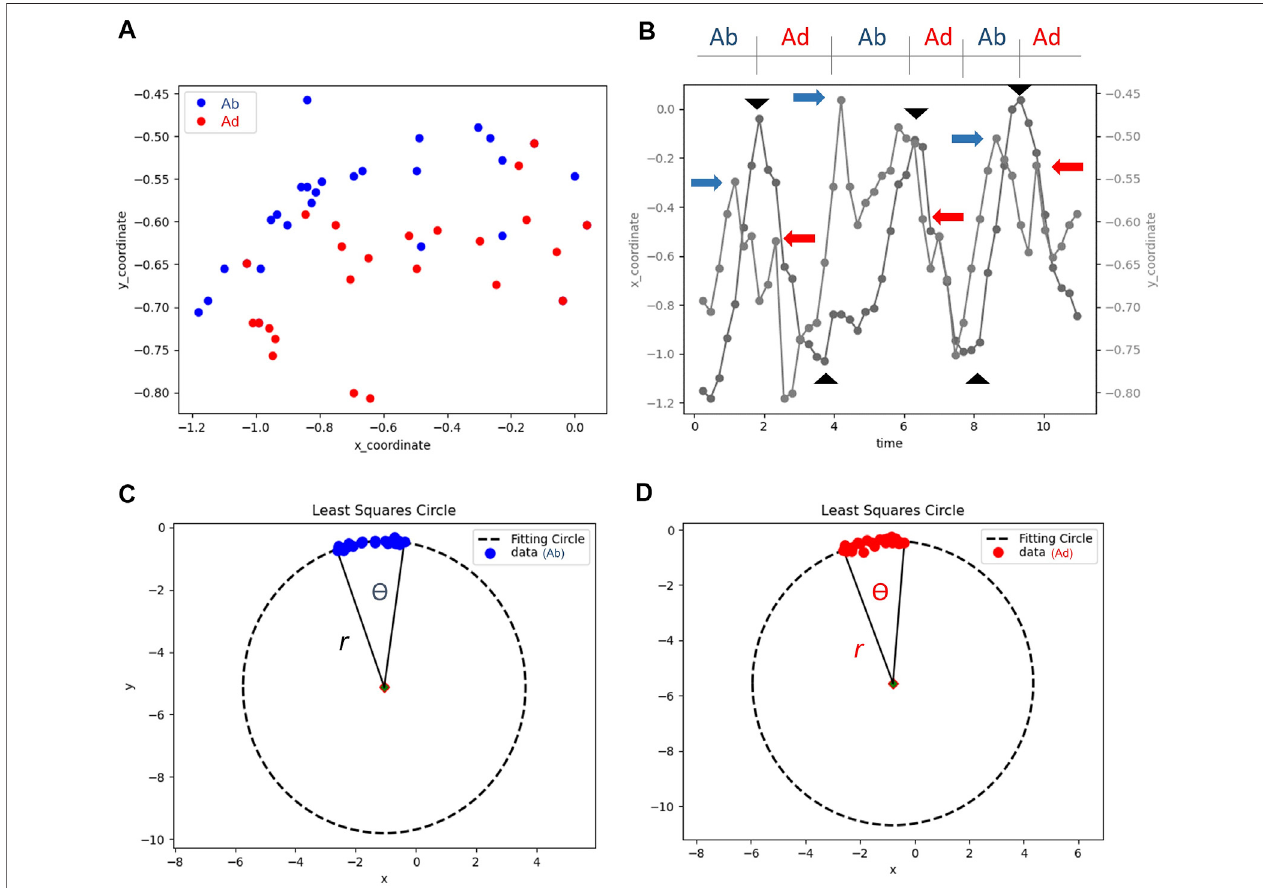
FIGURE 2 | The coordinate of the greater tuberosity in relation to the lateral acromial edge during the three repetitions of arm abduction and adduction (A) ; the locationofthegreatertuberostiy on thehorizontal (X)and vertical (Y)axes inaccordance totime (B) .Thepeaks and troughs(black arrowheads)onthetrajectoryoftheX axis are used to de fi ne the abduction (Ab) and adduction (Ad) phases. The blue arrows inthe abductionphase and the red arrows in the adduction phases indicated the pointswheretheminimalverticalacromiohumeraldistanceswereobtained.Thelocationsduringtheabduction (C) andadduction (D) phasesare fi ttedonacircleto calculate the rotation radius ( r ) and angle ( Ѳ ) of the humeral